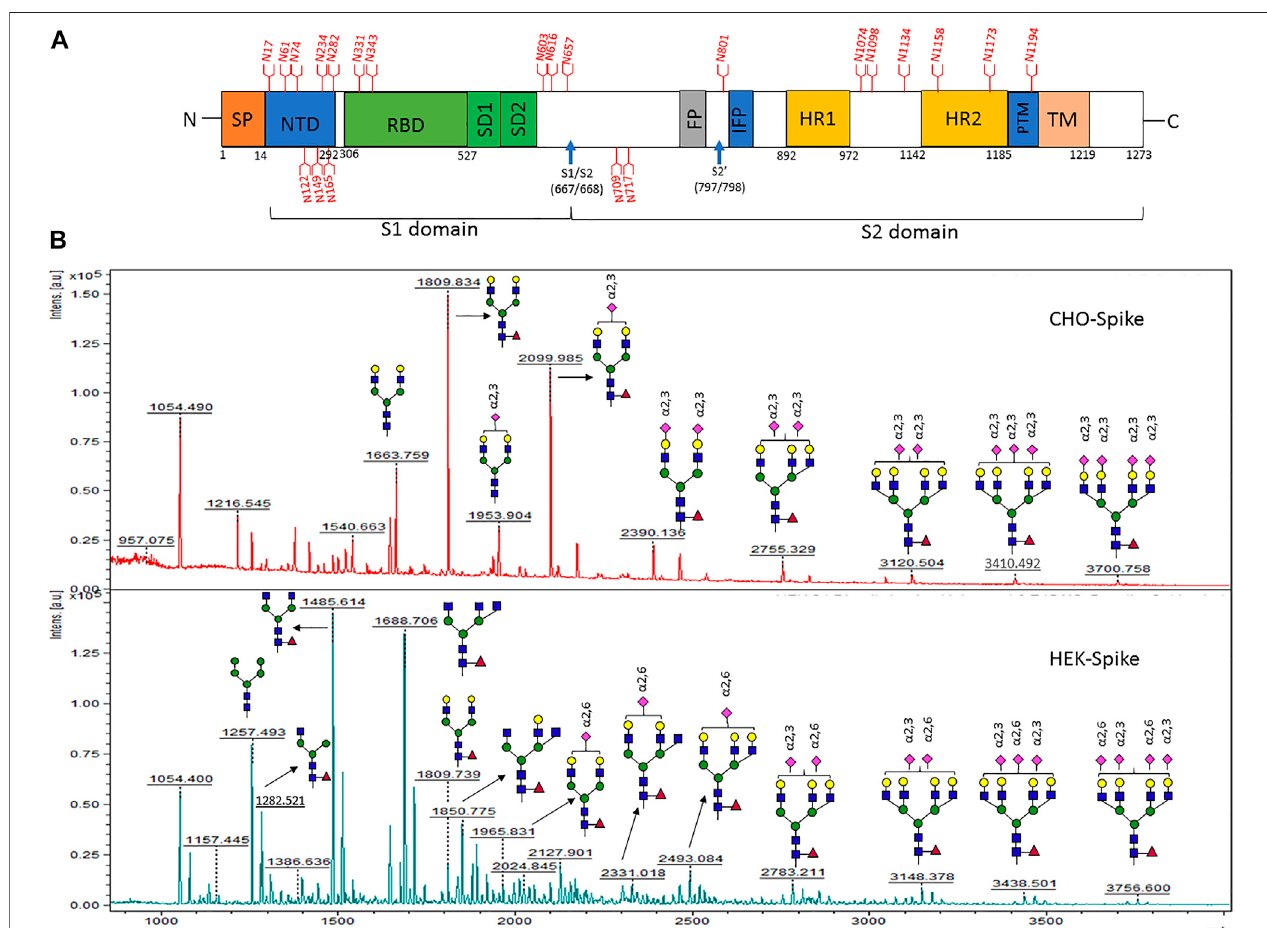
FIGURE 3 | (A) Schematic diagram of the SARS-CoV-2 Spike protein. Blue arrows indicate the S1 – S2 and S ′ proteolytic cleavage sites at residues R667 and R797, respectively. 22 N-glycan sites are labeled in red. (B) the glycomic analysis of released N-glycans of recombinant full-size spike protein from CHO (upper lane) and HEK (lower lane) with sialic acids modi fi ed by dimethylamidation and amidation, depending on their linkages. (C – F) the summaries of high-mannose types (C) , N-glycan type distribution (D) and sialylation linkage distribution (E) identi fi ed from released N-glycans of CHO-Spike and HEK-Spike.